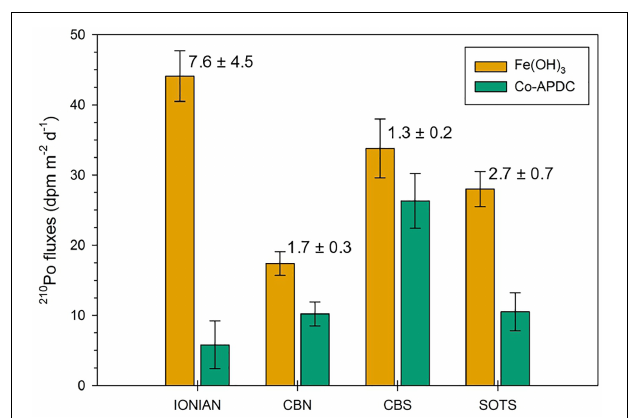
FIGURE 6 | 210 Po fluxes calculated from integrating the 210 Po deficit down to the base of the primary production zone using the Fe(OH) 3 (yellow) and Co-APDC (green) precipitation methods. Labels indicate the ratio between the Fe(OH) 3 -derived to the Co-APDC-derived